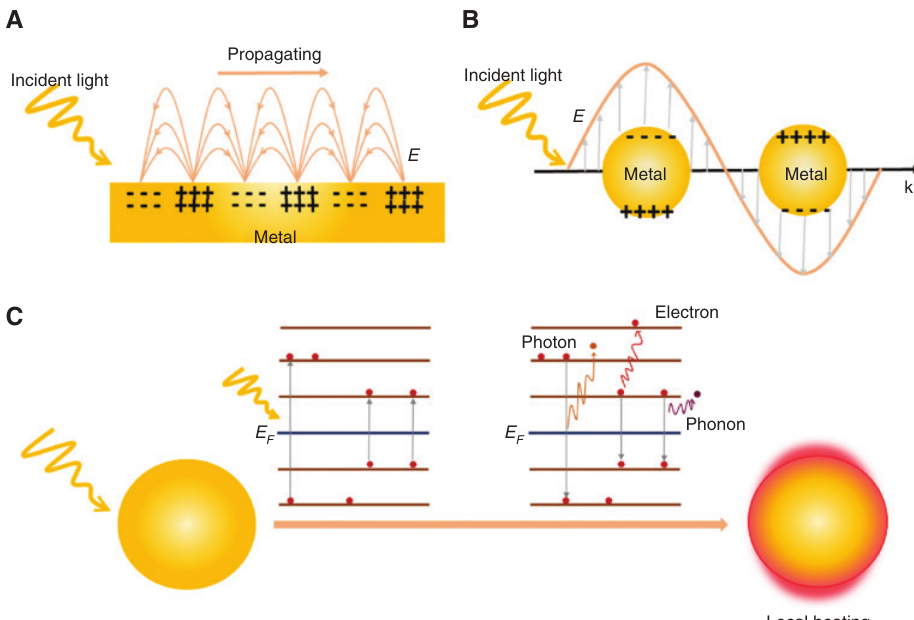
Figure 1: Schematics of the surface plasmons. (A) Propagating surface plasmon generated (SPP) at the metal-dielectric interface; (B) localized surface plasmon resonance (LSPR) generated on the metal nanoparticles; (C) surface plasmon decays in three different ways (electron-to-photon, electron-to-electron, and electron-to-phonon) and ultimately generates local